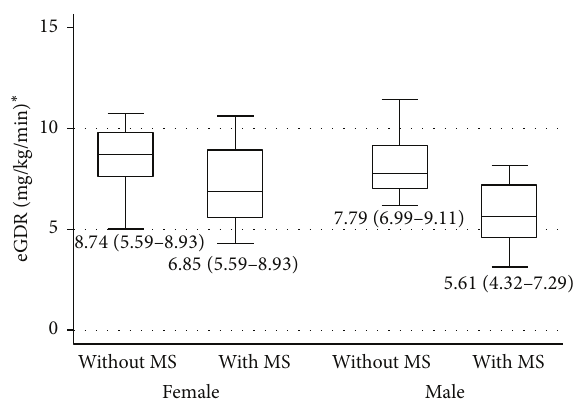
Figure 1: Estimated glucose disposal rate (eGDR) levels in male and female patients with and without MS. ∗ Data is presented as median